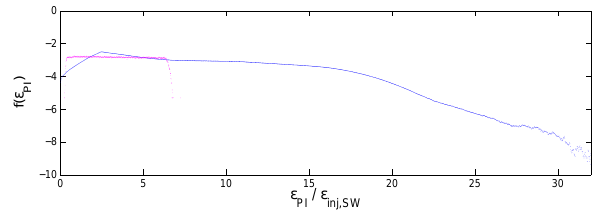
Fig. 10. Pickup proton energy distribution functions, kinetic energy normalised to E inj , SW vs. normalised frequency on a log 10 scale. Colours are as in Fig.